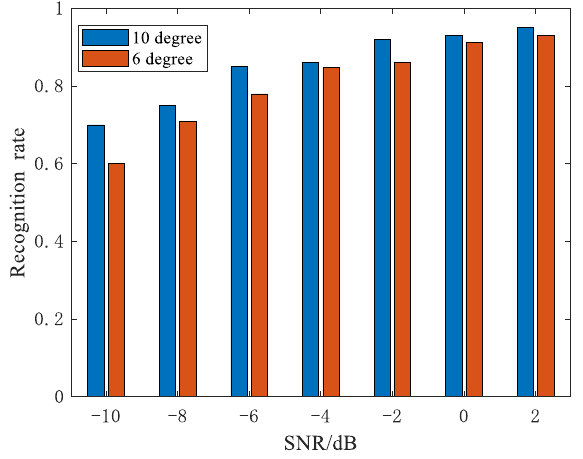
Figure 10. Recognition rate under different change intervals.